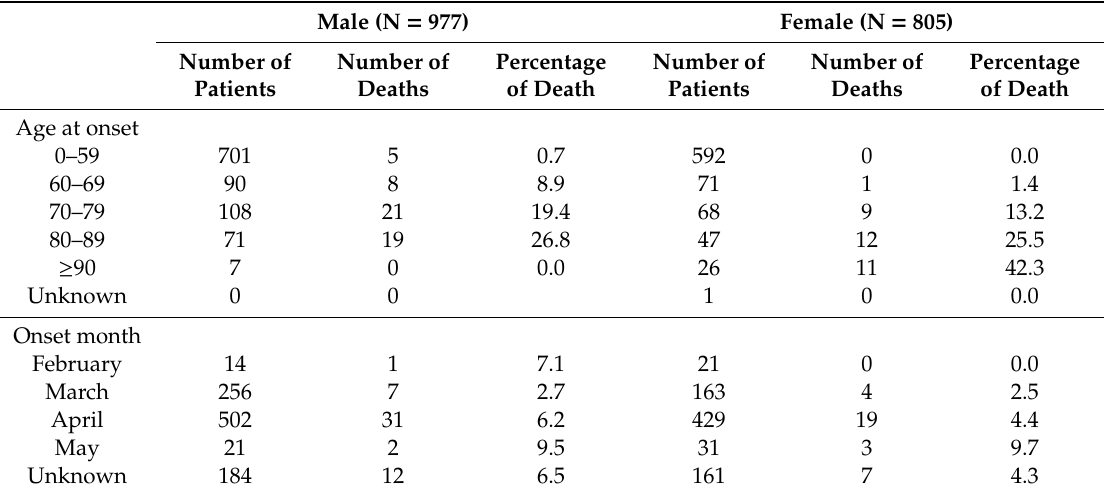
Table 3. Characteristics of patients included in the analysis of